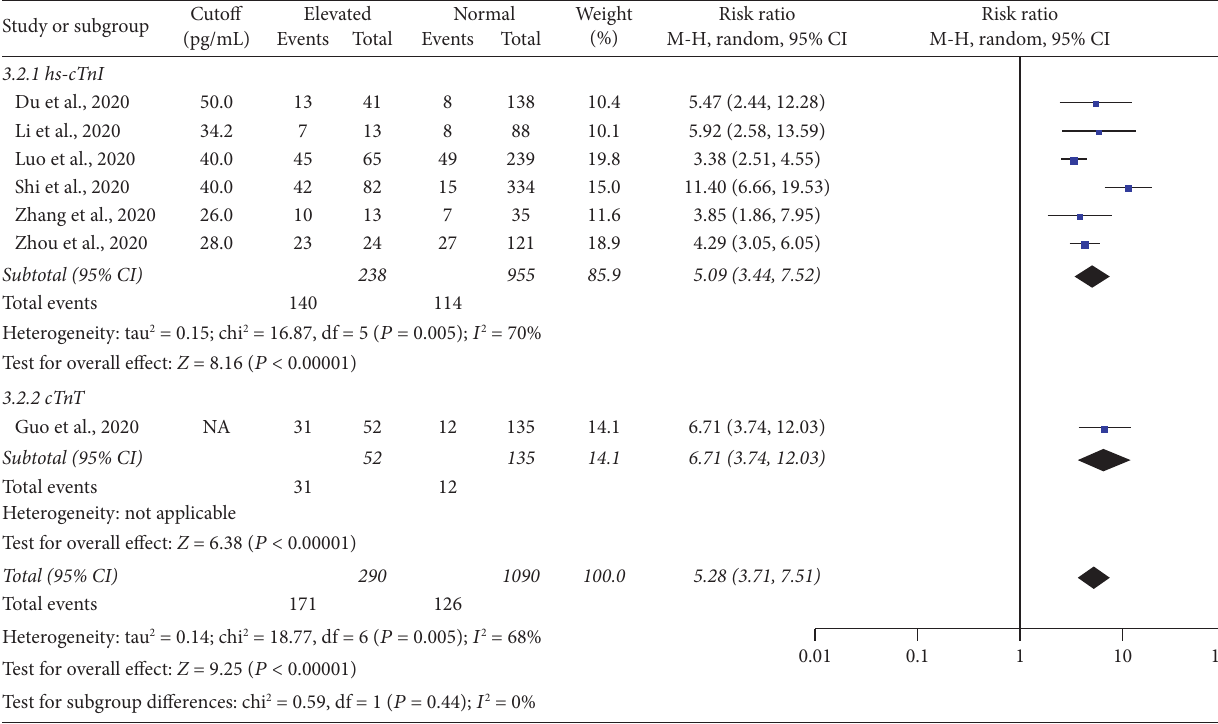
Figure 3: A forest plot showing the risk of death among COVID-19 patients with elevated and normal cTn on